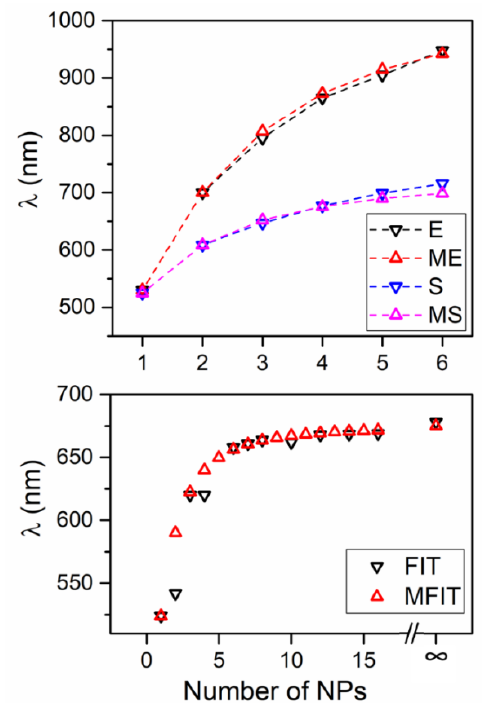
Figure 4. Comparison of results obtained by the variational method with data presented in literature. E (Experimental), S (electrodynamic Simulation), and FIT (Finit Integration Technique) have been taken from References [22,24,26], respectively. ME ( ω 0 = 2.34 eV, β = − 0.57 eV), MS ( ω 0 = 2.36 eV, β = − 0.33 eV), and MFIT ( ω 0 = 2.37 eV, = −0.27 eV) are the results calculated by the Variational Method for the appropriate systems.